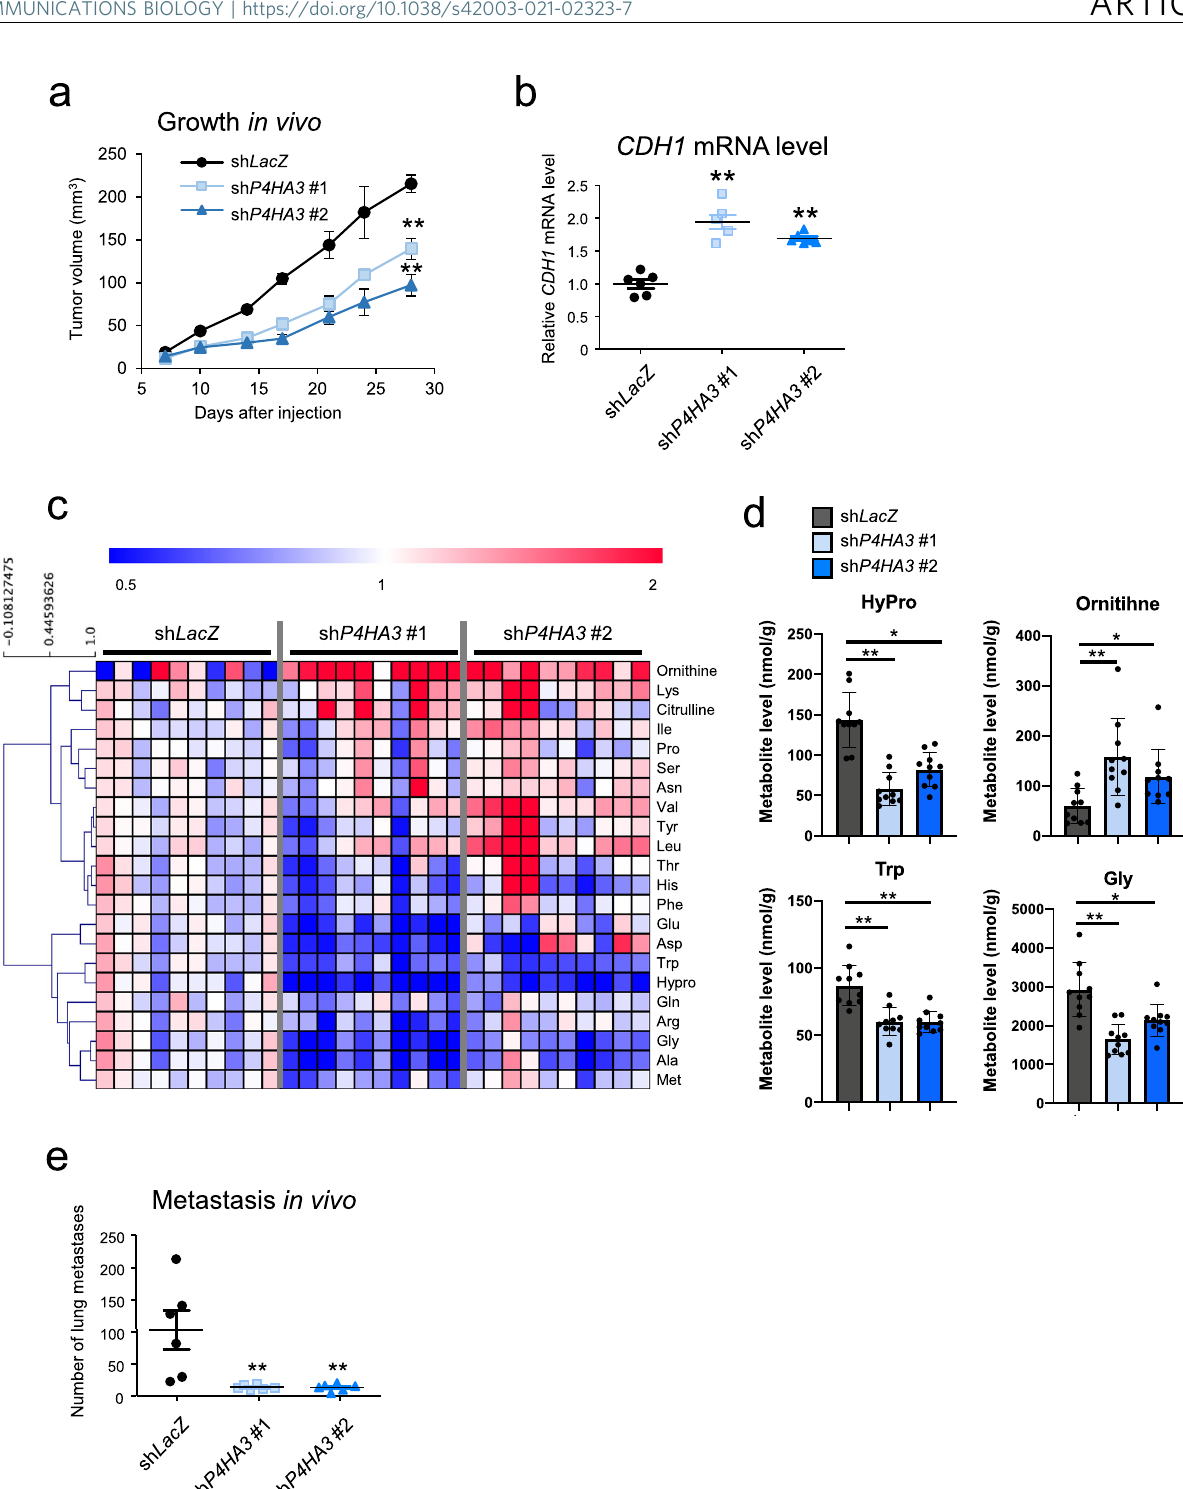
Fig. 7 Effect of P4HA3 depletion on tumor growth and metastasis in vivo. a Rate of growth following subcutaneous implantation of control and P4HA3- knockdown A549 cells; n = 6 per group. Data represent mean ± SEM. ** P < 0.01. b CDH1 mRNA levels in tumors derived from sh LacZ , sh P4HA3 #1, and sh P4HA3 #2 A549 cells. c Altered amino acids in tumors derived from P4HA3 -knockdown A549 cells ( n = 10 per group). Metabolite levels in each sample were converted to a fold-change relative to the average metabolite level of the paired control (sh LacZ ). Red and blue indicate higher and lower levels, respectively, of metabolites in the P4HA3 -knockdown tumors (sh P4HA3 #1 and sh P4HA3 #2) compared to those in the control tumors (sh LacZ ) (white). d Levels of hydroxyproline, Gly, Trp, and ornithine in the P4HA3 knockdown tumors. Data are presented as mean ± SEM. * P < 0.05, ** P < 0.01. e Lung metastatic burden of i.v. injected control and P4HA3 -depleted A549 cells 56 days after inoculation. Lung metastatic foci were counted; n = 6 per group. Data are presented as mean ± SEM. ** P <